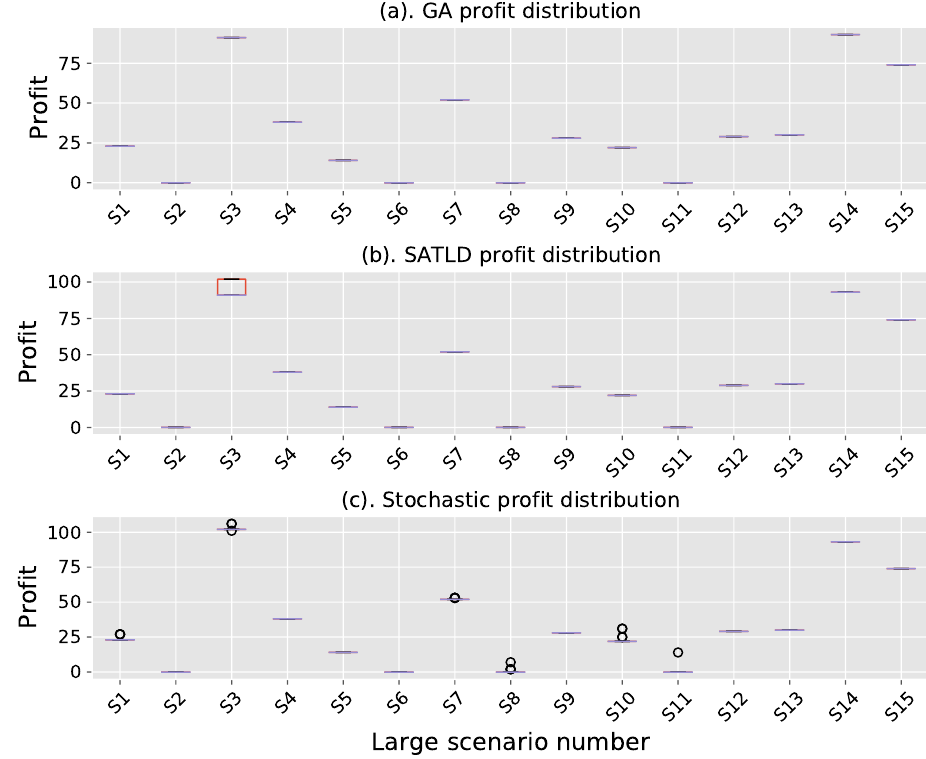
Figure 10. Distribution in large